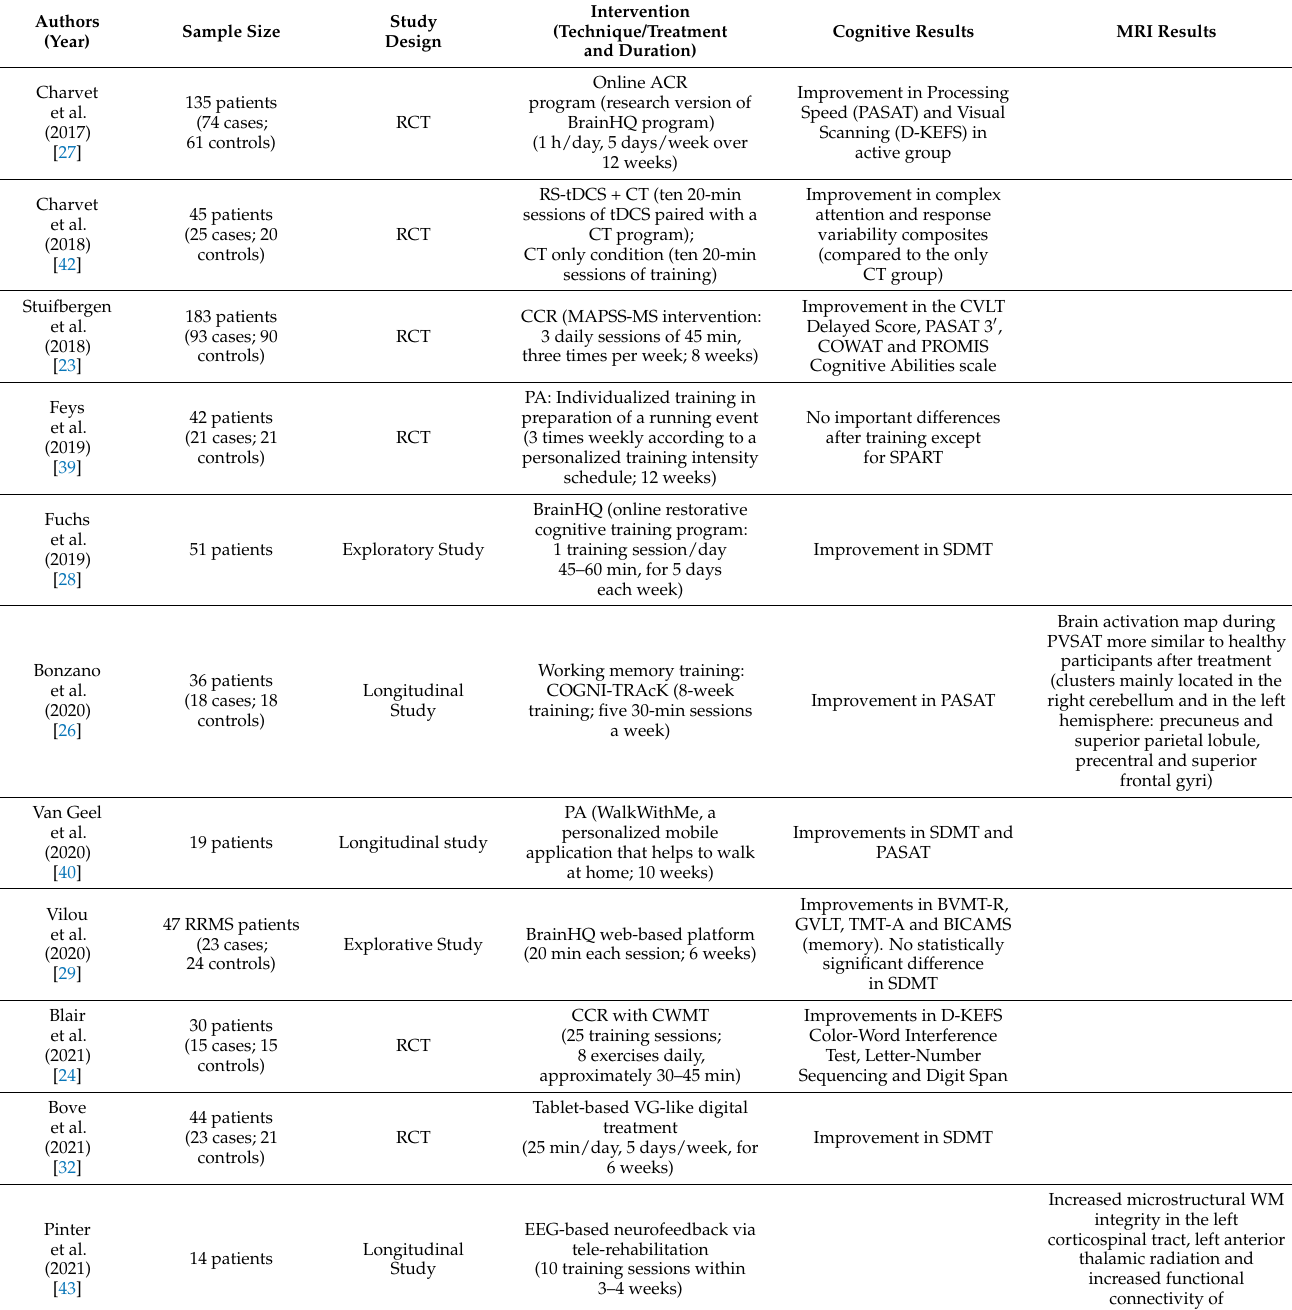
Table 3. Cognitive and Motor